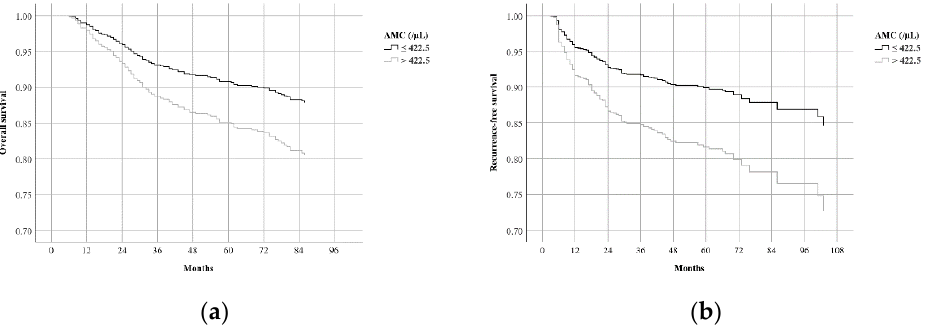
Figure 2. Adjusted survival curves according to AMC in all patients ( n = 692): ( a ) Overall survival curve; ( b ) recurrence-free survival curve. AMC, absolute monocyte count. Table 5. Multivariate Cox regression analysis for recurrence-free survival in patients with an absolute Multivariate analysis was repeated for subgroups categorized according to blood cell lymphocyte count > 2074.0/ µ L ( n = counts and ratios. As with the results of the analysis of all patients ( n = 692), T stage and either N stage or stage group were found to be valid prognostic factors for OS and RFS in all subgroups. The type of adjuvant treatment did not affect the treatment outcomes in any subgroup, except for one: in the subgroup with high ALC (>2074.0/µL), patients who